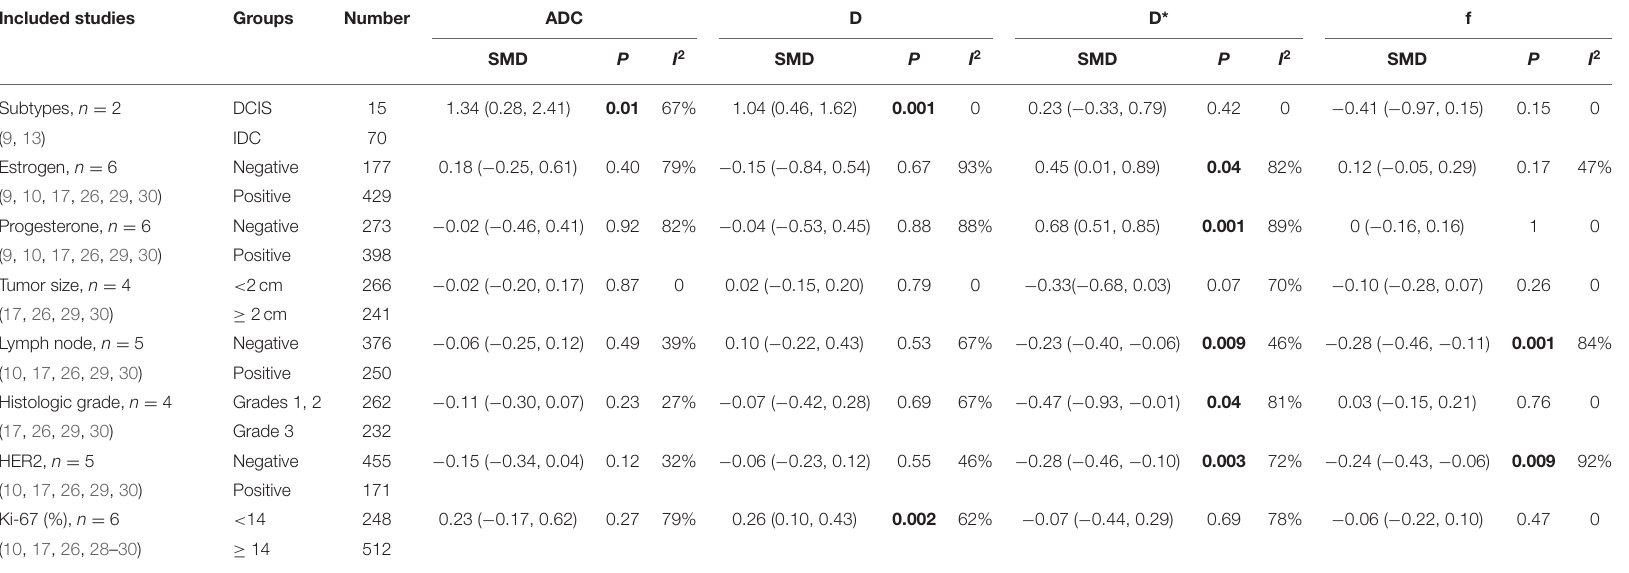
TABLE 3 | Differential information between DCIS and IDC and the pathologic prognostic